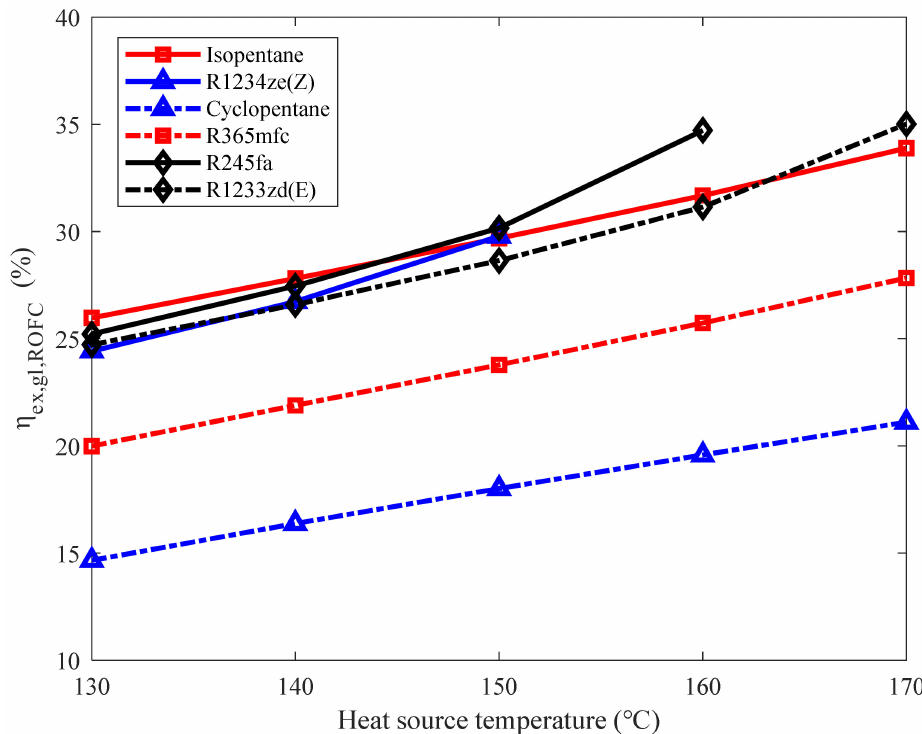
Figure 10. Effect of heat source temperature on global exergy